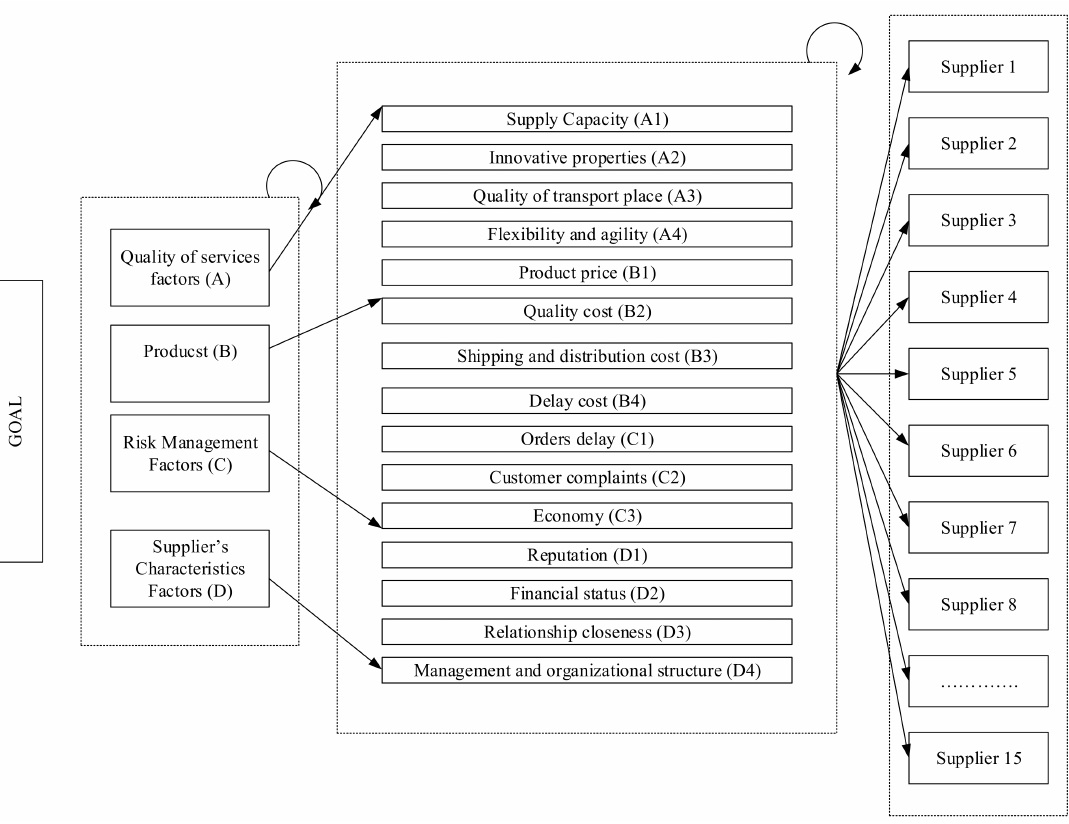
Figure 5. The hierarchical structures of the FAHP model.